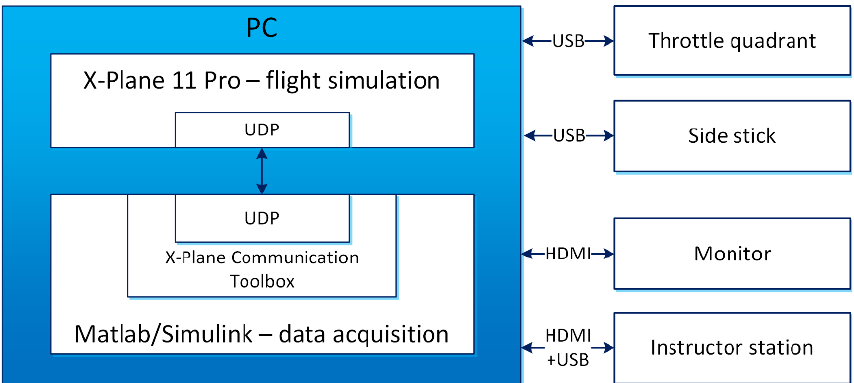
Figure 9. Block diagram of the stand for flight simulation and data acquisition.